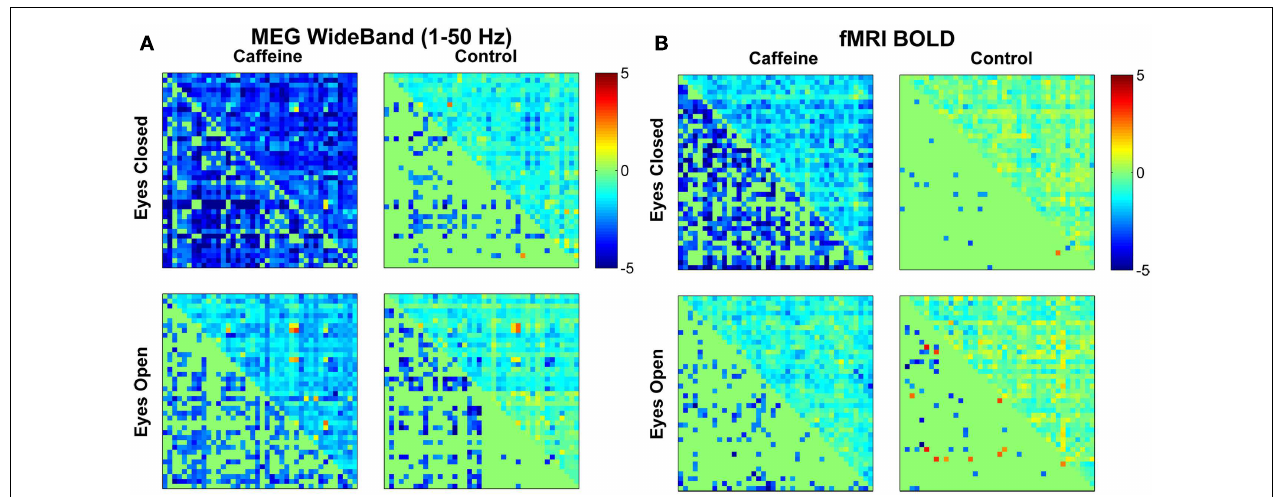
t -statistic for each ROI pair (in a mirrored fashion where only significant ( p < 0.05) entries are filled in). A negative value (blue color) corresponds to a caffeine-induced decrease in connectivity, while a positive value (red) corresponds to an increase in connectivity. Qualitative assessment shows broad decreases in connectivity due to caffeine for the eyes closed condition and to a lesser extent in the eyes open condition, for both